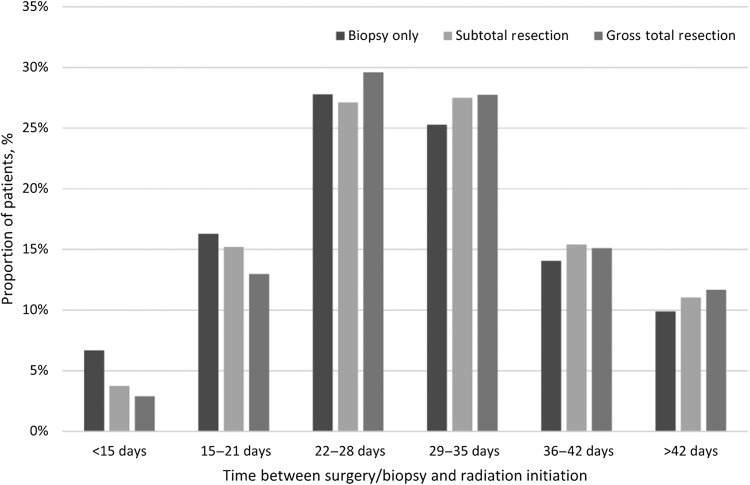
Distribution of time to radiation initiation from date of biopsy/surgery by extent of resection in entire study cohort.